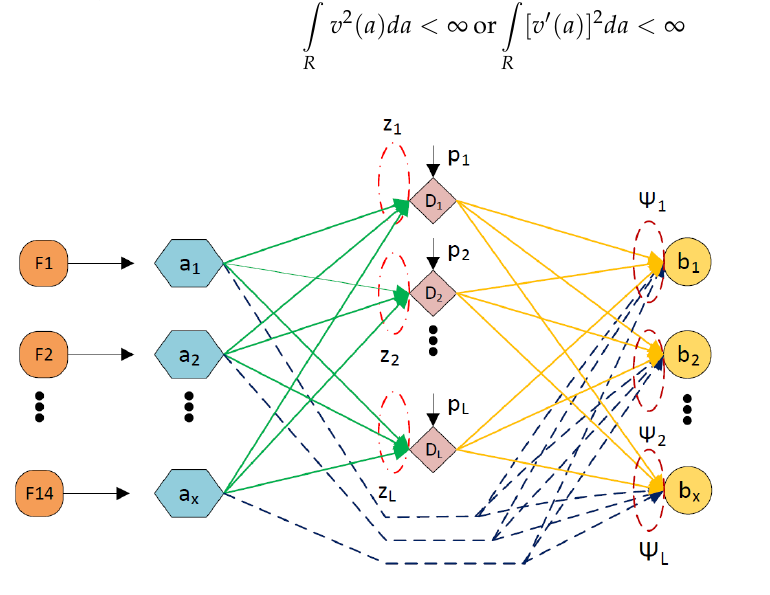
Figure 1. RVFLNs